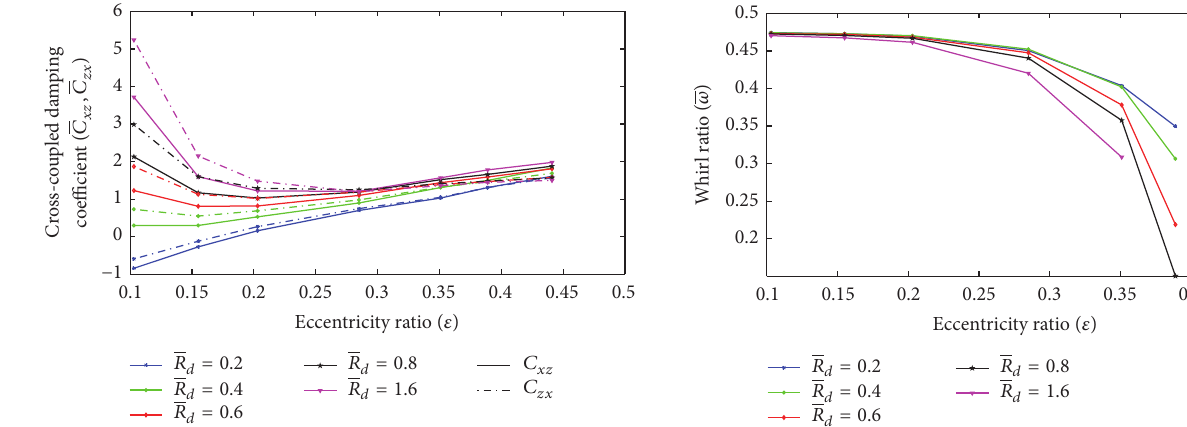
Figure 11: Effect of relief track depth ratio on cross-coupled damping coefficient.